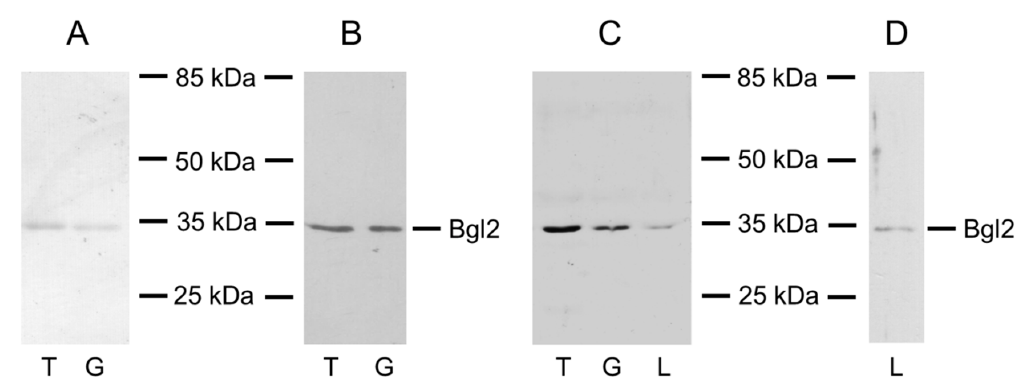
Figure 1. Analysis of extracts from Saccharomyces cerevisiae cell walls obtained with 0.1 M Tris for 3.5 h at 30 ◦ C—T, with 6 M GuHCl for 2 h at 30 ◦ C—G ( A – C ) and with water at 100 ◦ C after removal of lipid component—L ( C , D ). PAGE stained with Coomassie G-250 ( A ) or with silver nitrate staining ( C ) and Western blot stained with antibodies against Bgl2 ( B , D ).